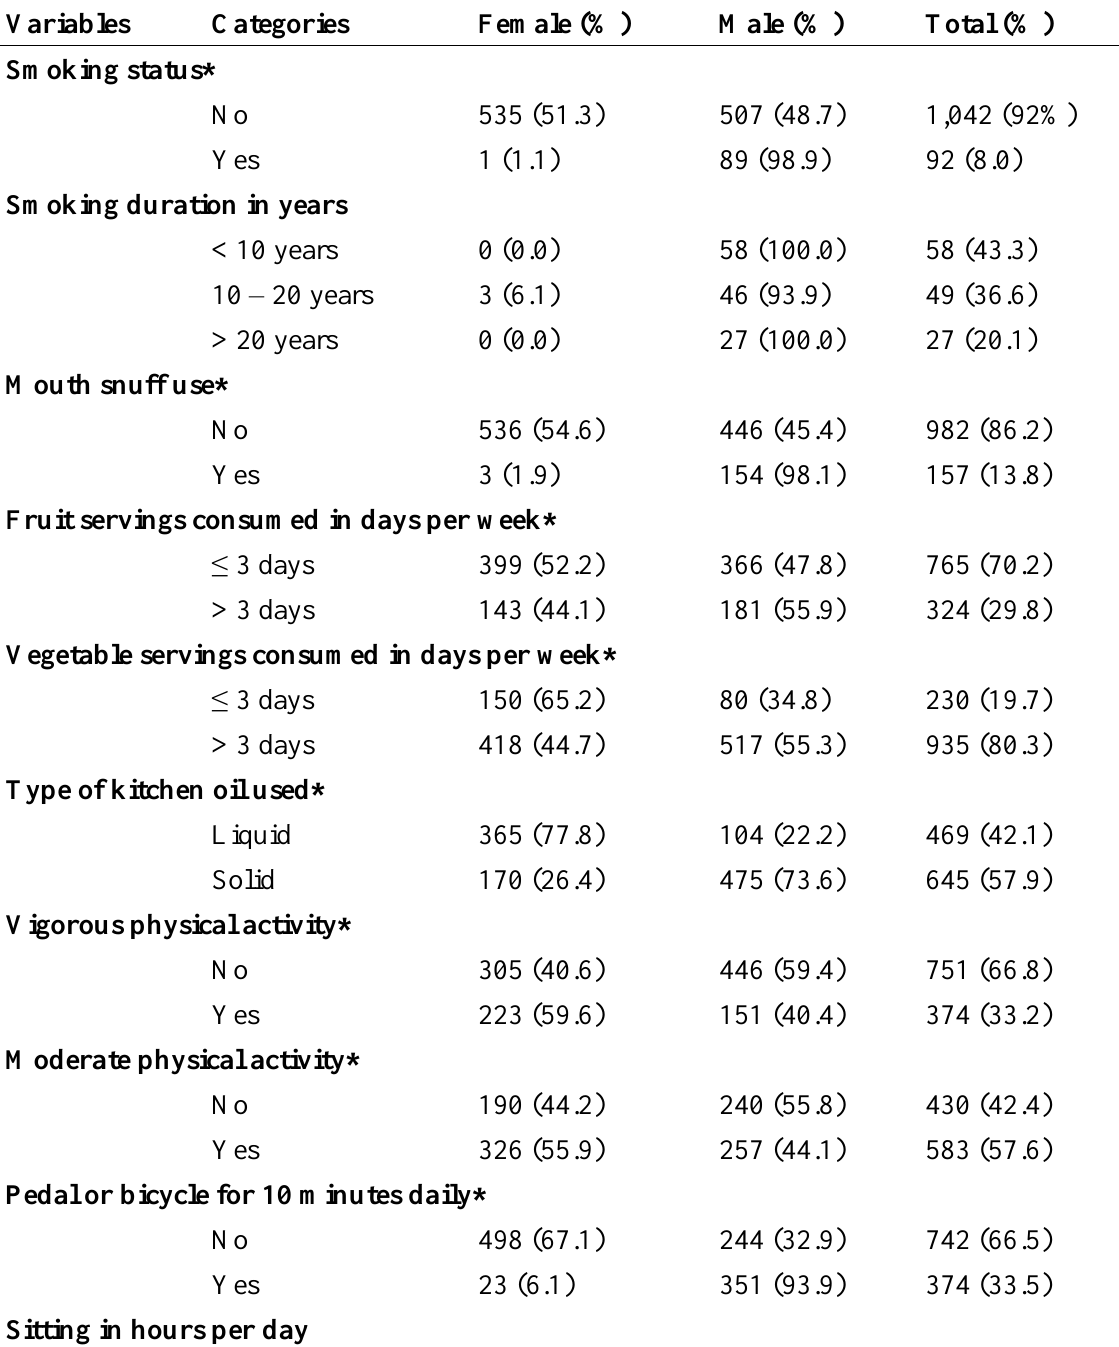
Table 2: Frequency distribution of behavior risk factors of those surveyed using the WHO STEPS in Jalalabad, Nangarhar,